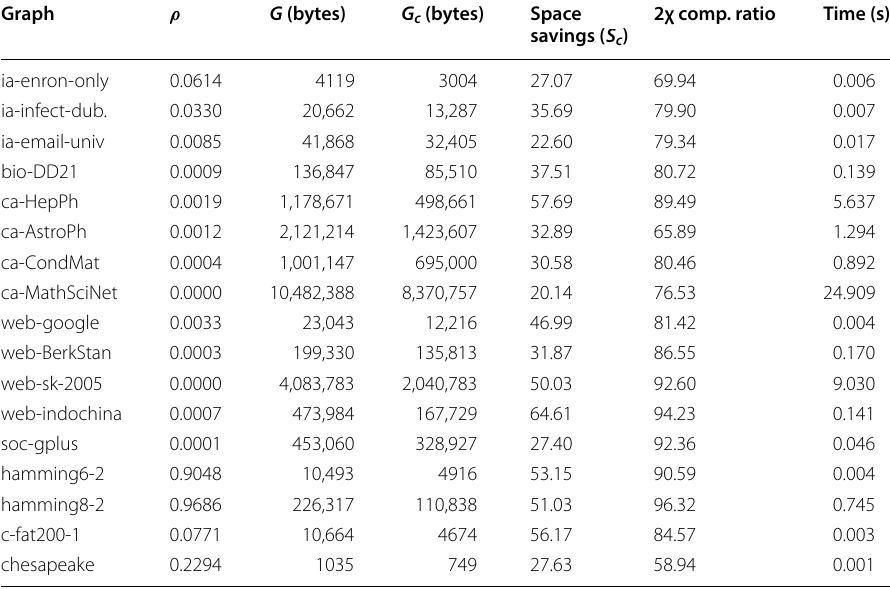
Table 1 GraphZIP compression results for a variety of real-world graphs. Note S c denotes the space saved by GraphZIP defined as S c = 1 − G c G